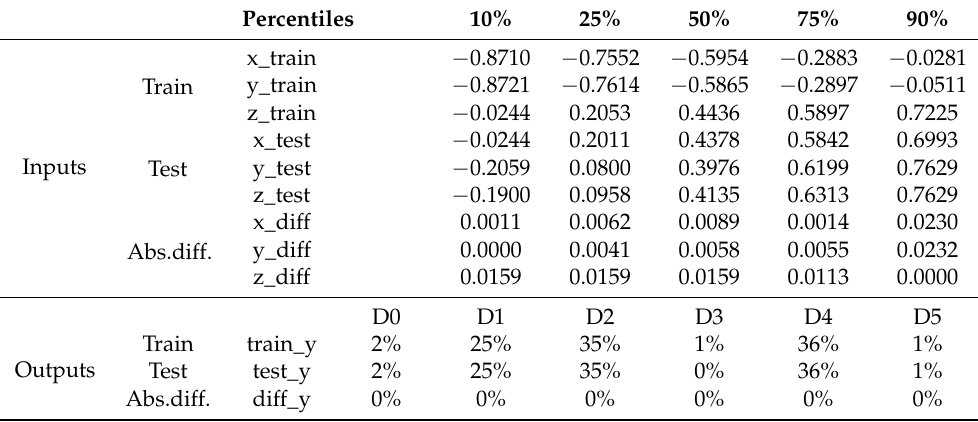
Table 7. Training and Testing dataset similarity for CEN